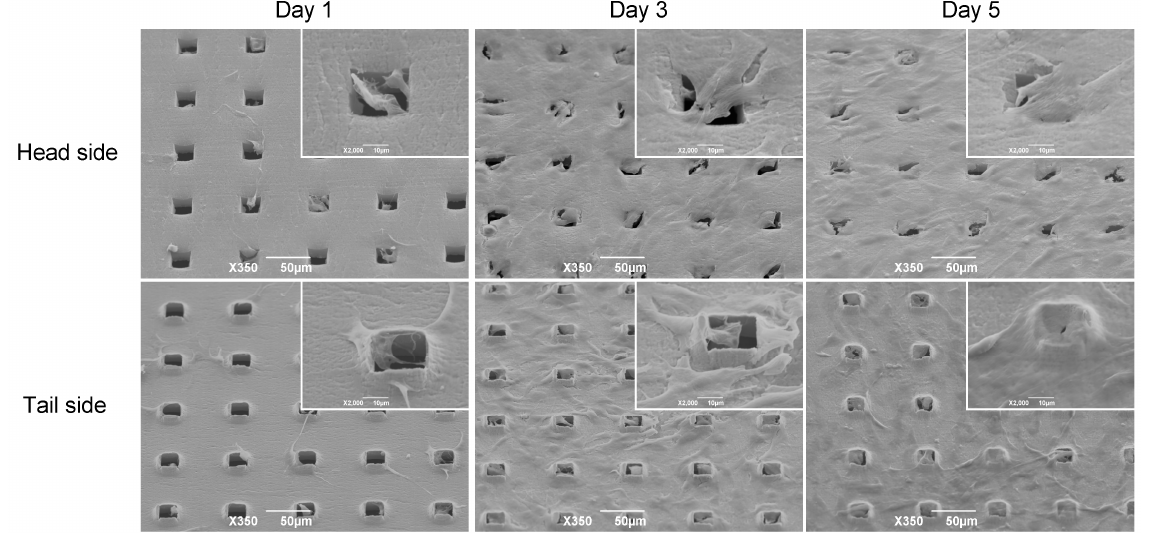
Figure 4. The visualization of cellular patterns on the microperforated substrate using scanning electron microscopy (SEM). The C3H10T1/2 cells were cultured on the substrate over a 5-day period. The cells cultured on the head side are shown in the top row, and those cultured on the tail side are shown in the bottom row. The SEM images are shown at 2 magnifications (the scale bars represent 10 or 50 μ m).